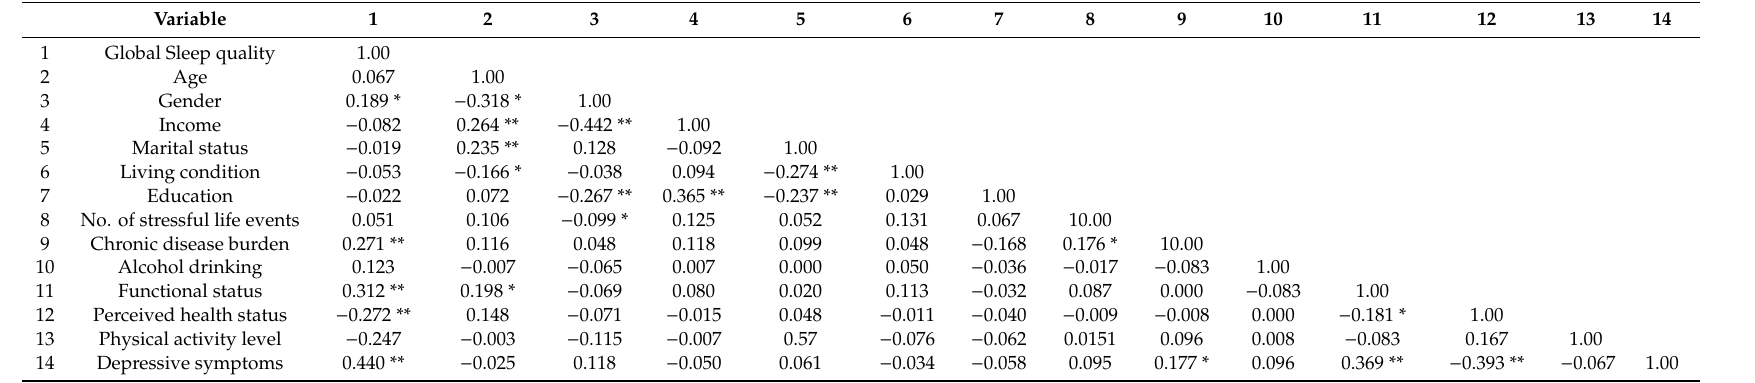
Table 2. Association between socio-demographic features, lifestyle factors, health-related, psychological factors, and sleep quality in mild cognitive impairment (MCI, n =